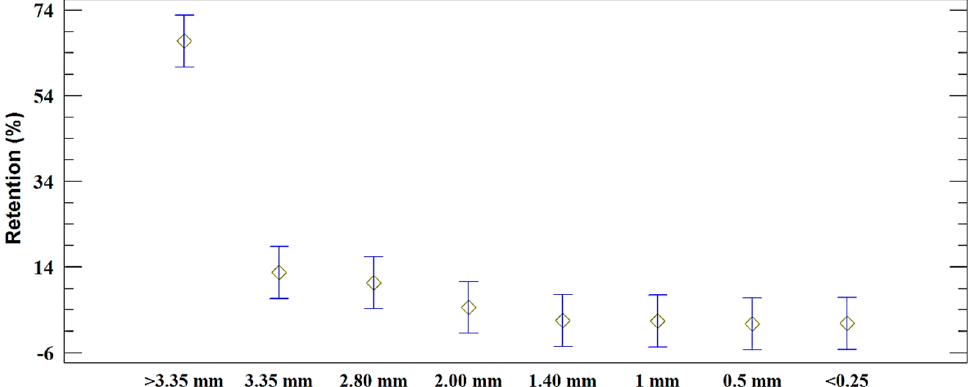
Figure 3. Granulometric distribution of the shavings samples (%).